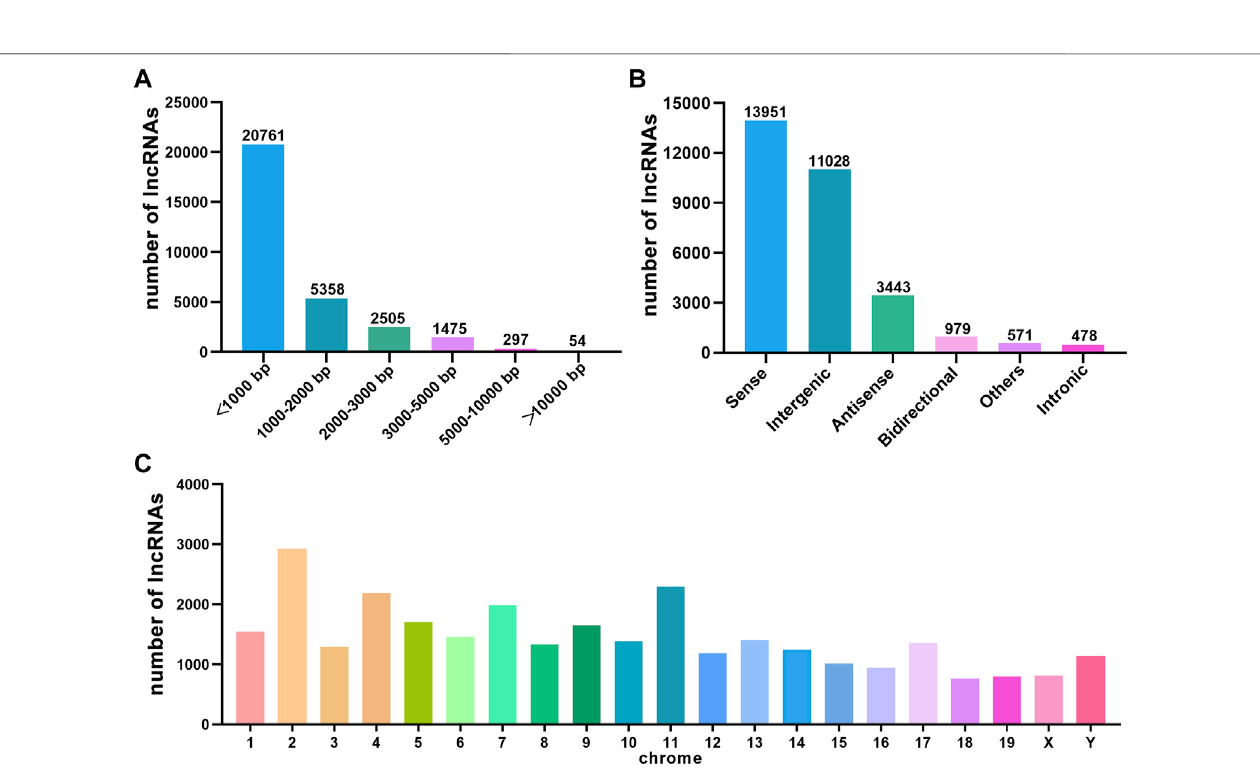
FIGURE 2 | The characteristics of HE mouse lncRNAs detected by RNA sequence. (A) Length distribution of lncRNAs. (B) Classi fi cation of lncRNAs. (C) Chromosome distribution of